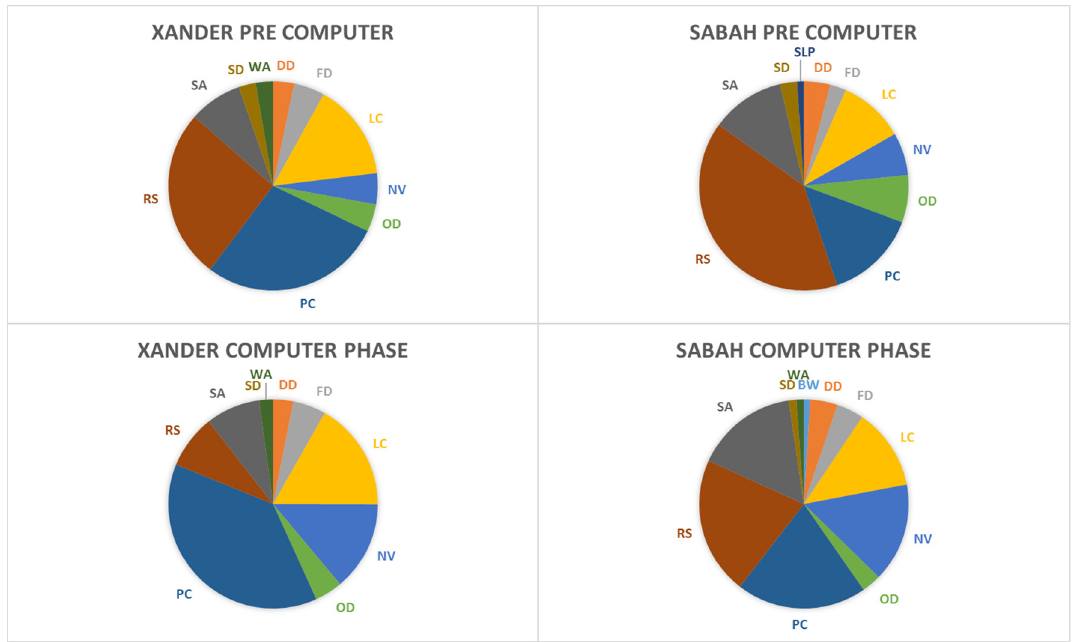
Figure 3. Activity budgets before and after the introduction of the computer (DD = Door Directed; FD = Feed; LC = Locomote; NV = Not Visible; OD = Object Directed; PC = Pace; RS = Rest; SA = Stationary Alert; SD = Self-Directed; SLP = Solitary Play; WA = Water Interaction). Any behaviors accounting for less than 1% of the subject’s time were not included in the figure.